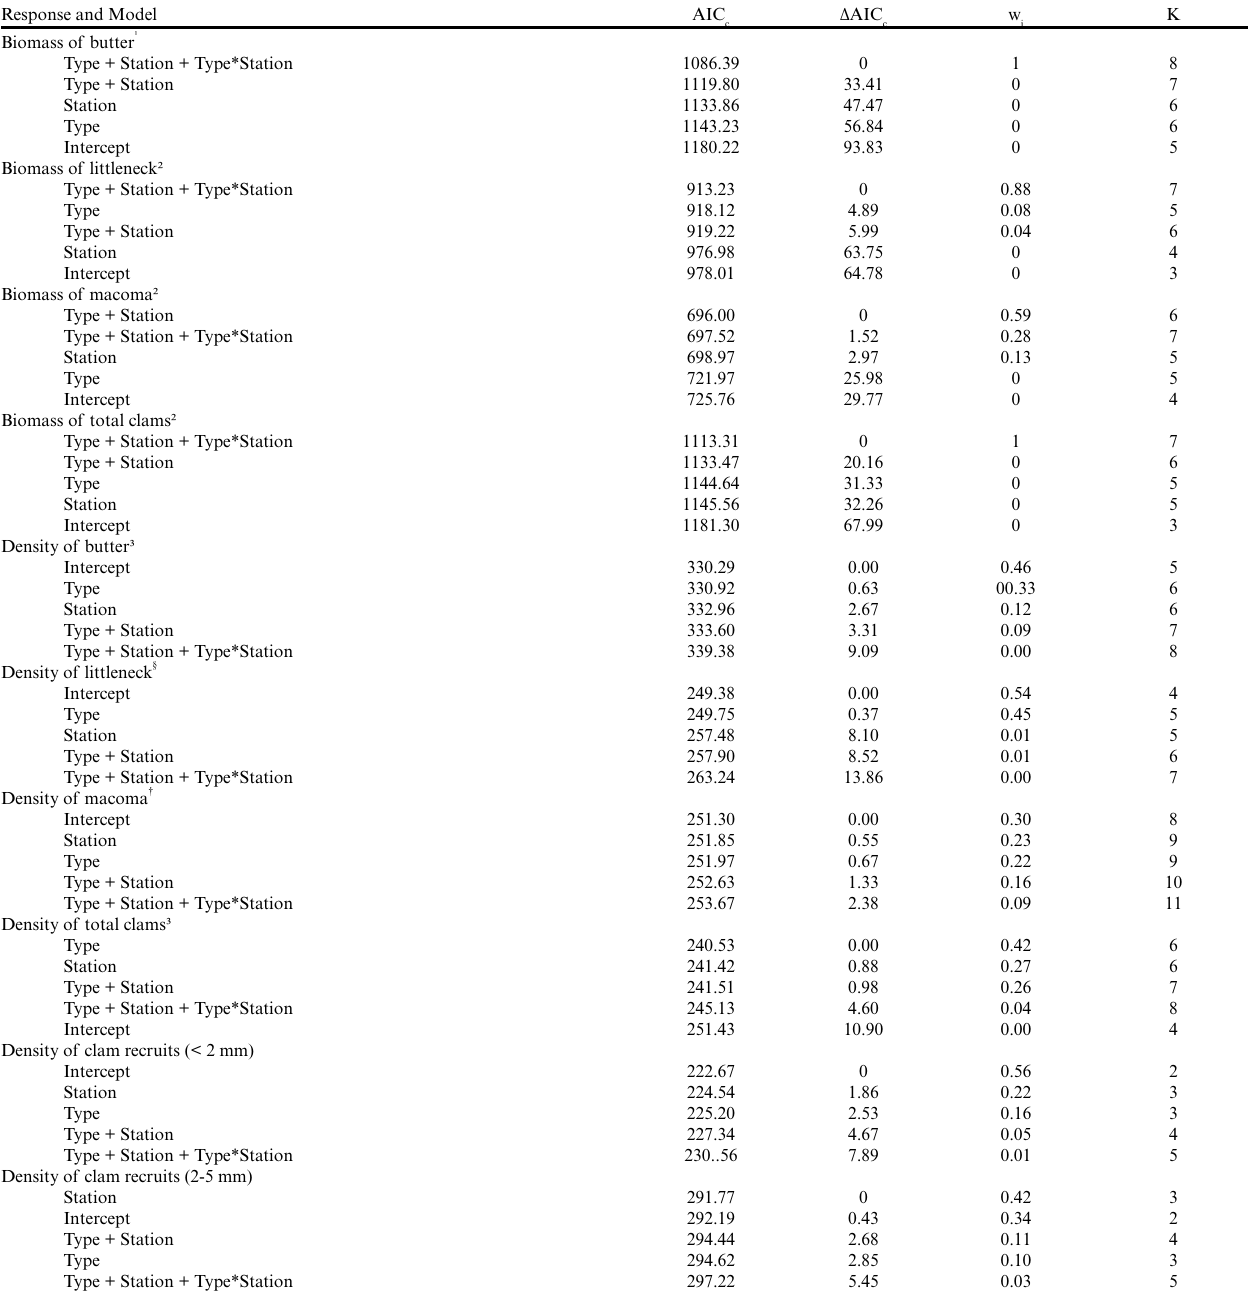
Table 2 . Strength of evidence for alternative candidate models examining the effects of beach type (clam garden versus nonwalled beach) and tidal station on the biomass and density of adult butter ( Saxidomus gigantea ), bentnose macoma ( Macoma nusata ), native littleneck clam ( Leukoma staminea ), and total clams, in addition to clam recruits, both < 2 mm and 2-5 mm. Models with parameters (K) were compared using small-sample bias-corrected Akaike’s information criterion (AIC normalized Akaike weights (W ) representing the strength of evidence for model i. All models include site as a nested, random factor, i and variance structures denoted as: ¹constant power variance structure, ²power variance structure, ³exponential variance structure, § identity variance structure fitted by type, † identity variance structure fitted by